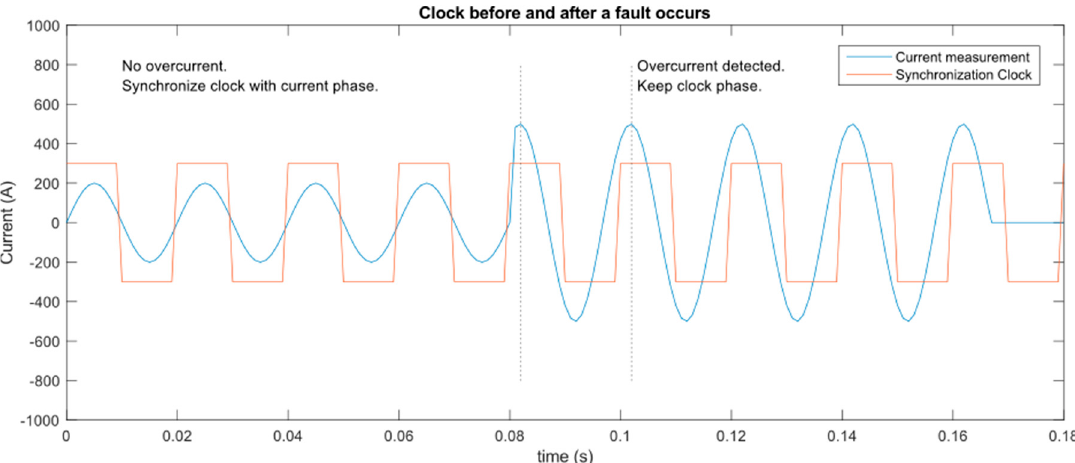
Figure 11. Clock synchronization using current measurements.